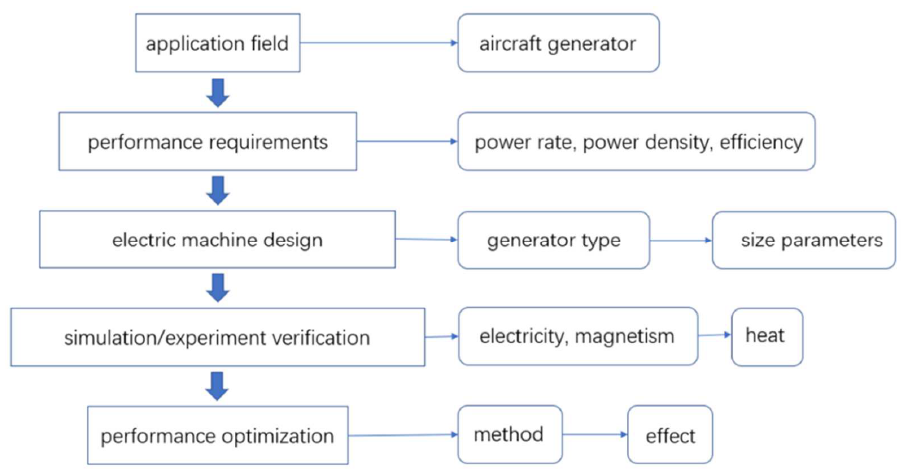
Figure 1. The design process of an HTS electric machine.